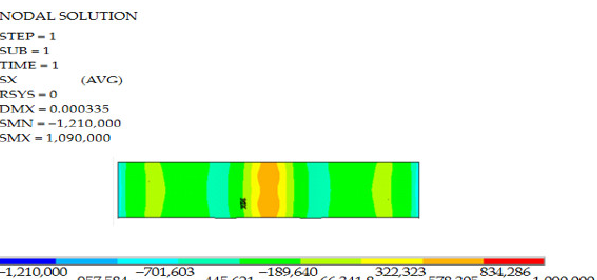
Figure 22. Stress distribution diagram of the base plate under fatigue load of 12 million applications (working condition 3). ( a ) Longitudinal stress of base plate; ( b ) lateral stress of base plate.